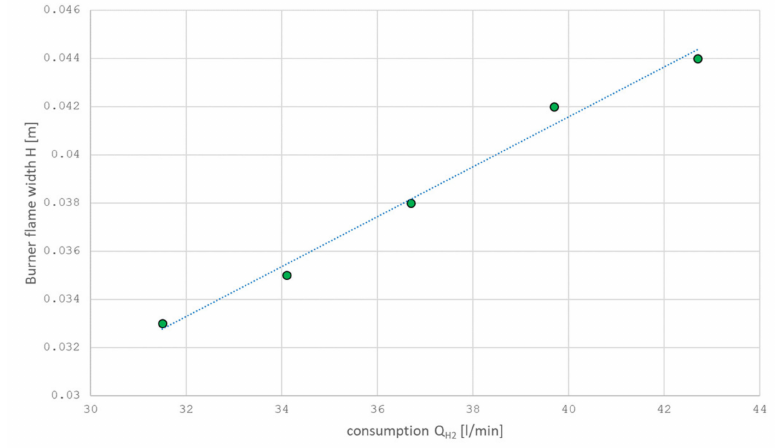
Figure 15. The dependence of the dispersion (width) H on the consumption Q H2 with a mobile burner.